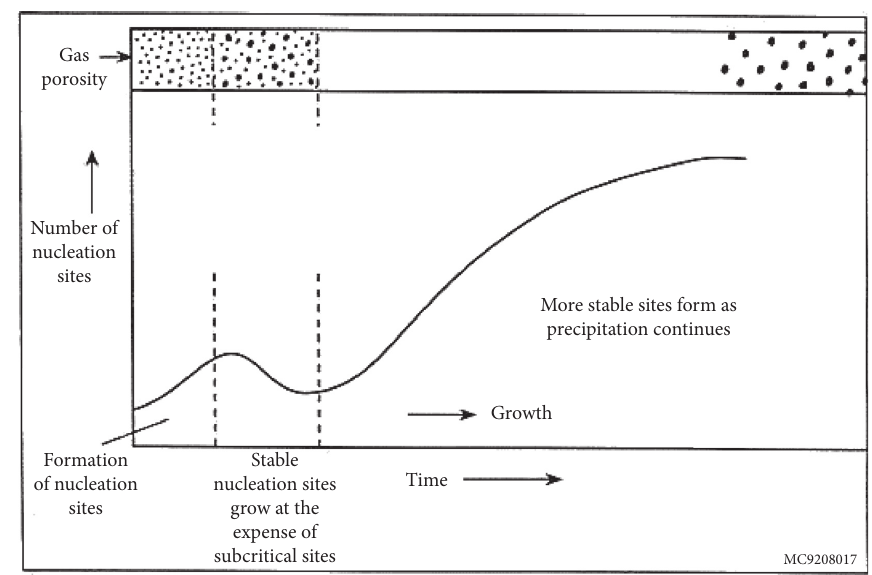
Figure 6: Representation of porosity development during solidification [26].